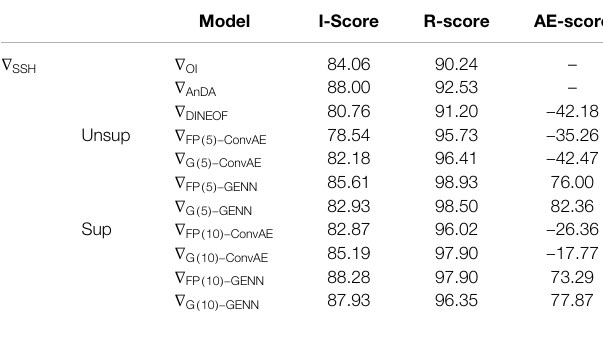
TABLE 3| Evalulation ofthe benchmarked methods forthe SSH case study using anunsupervisedandsupervisedtrainingstrategy:weevaluateforthegradient norm of the SSH fi elds ( ∇ SSH ) , the interpolation, and reconstruction scores, respectively, the I-score, as well as auto-encoding scores when relevant. For benchmarking purposes, we consider OI, AnDA, and DINEOF schemes. Regarding the proposed framework, we evaluate two settings using an iterative fi xed-point procedure: namely, FP(5)-ConvAE architecture based on aconvolutionalauto-encoderarchitecture andFP(5)-GENNbasedonaGibbs energy